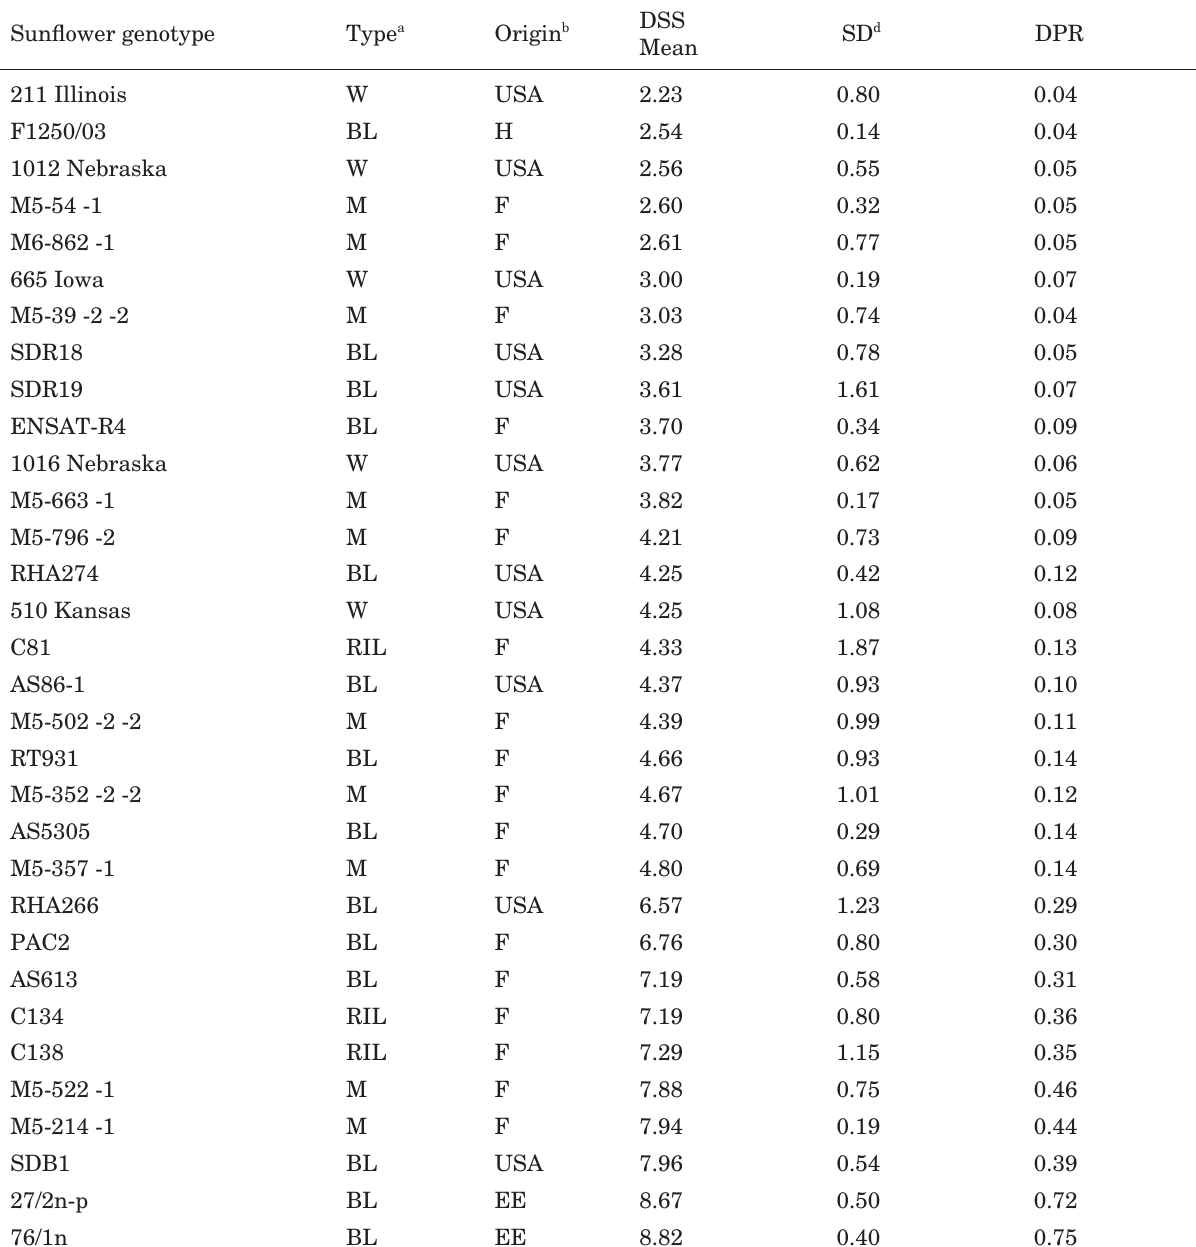
a BL, breeder’s line; RIL, recombinant inbred line; M, gamma-irradiated induced mutant line; W, wild type. b F, France; USA, the United States of America; H, Hungary; EE, Eastern Europe. c Disease severity score of 36 seedlings per genotype infected with Phoma black stem isolate MP6, seven days after petiole inocula- tion. A score of 1 (resistance) to 9 (susceptible) was given depending on the proportion of petiole area showing necrosis, where: 1, 0–5% necrotic area; 2, 6–10%; 3, 11–20%; 4, 21–30%; 5, 31–40%; 6, 41–60%; 7, 61–80%; 8, 81–99%; and 9, 100% petiole area with necrosis spreading downward into the stem. d Standard